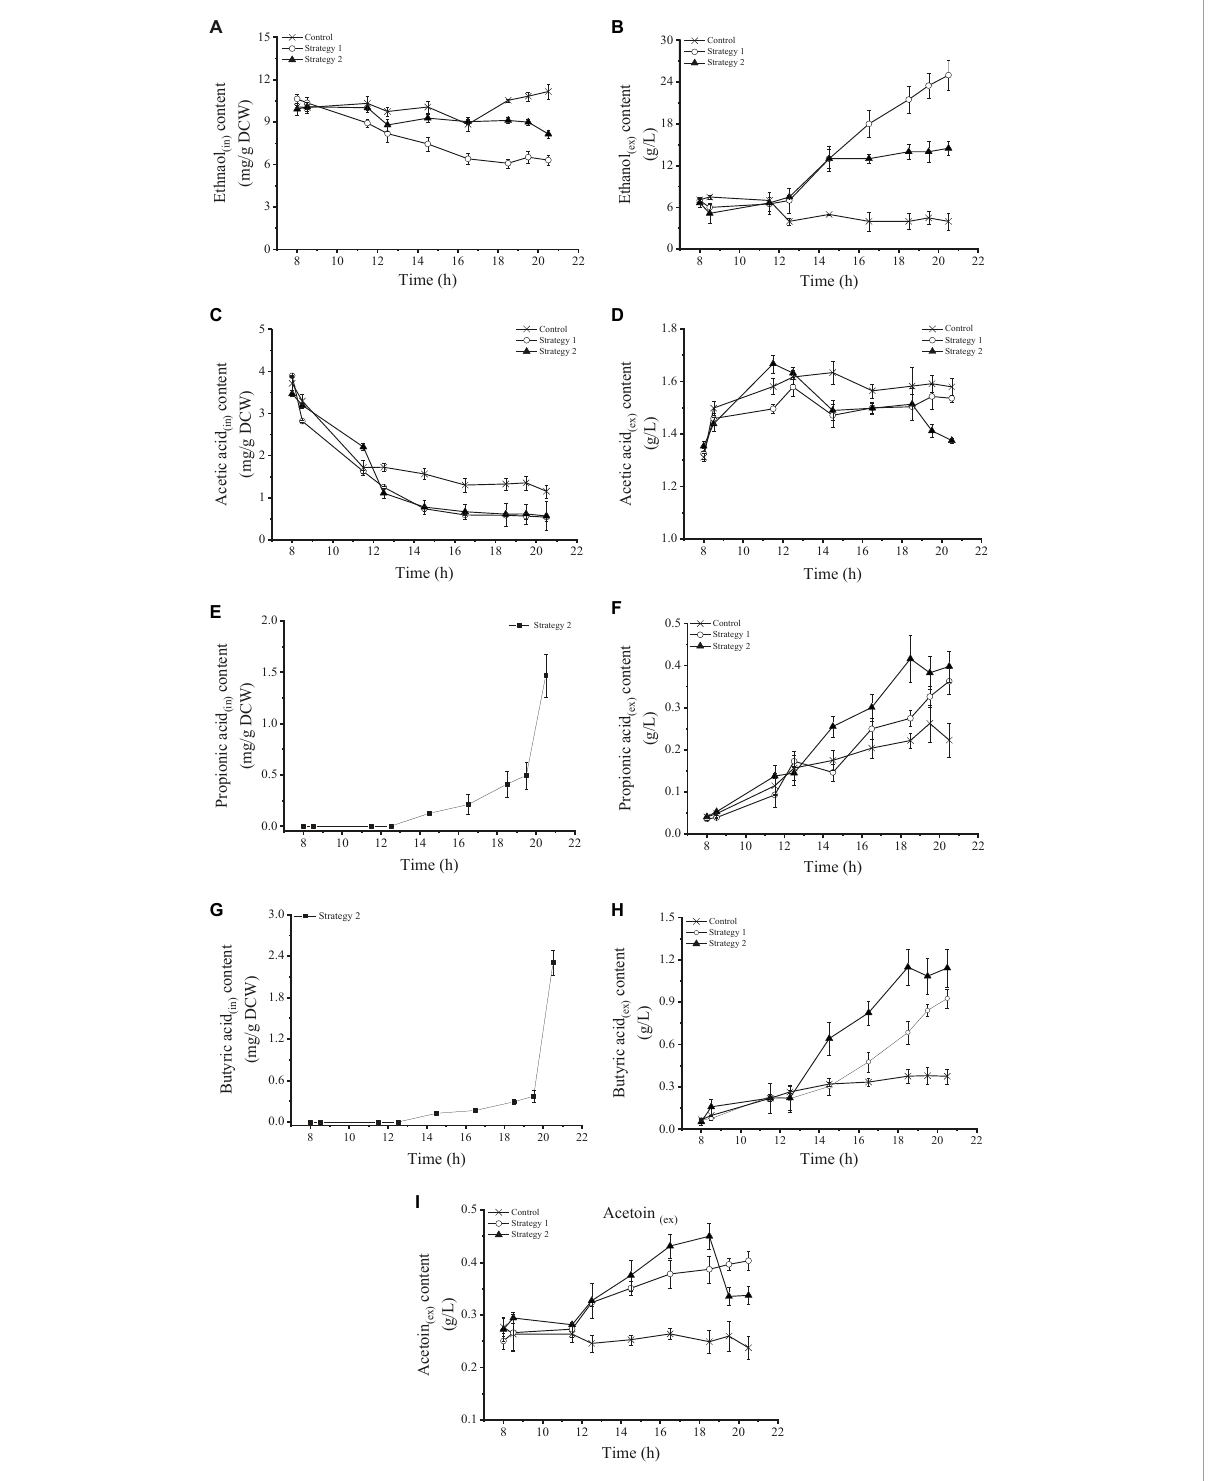
FIGURE3 (A–I) Changes in intracellular and extracellular overflow metabolite levels in Z. rouxii using three fermentation regulation strategies. “in” stands for intracellular material, “ex” stands for extracellular